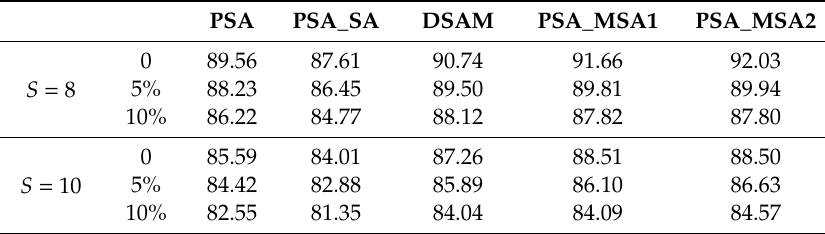
Figure 15. Comparison results of different SPM models for real land image1 with a 10% error in the proportional image ( S = 10). ( a ) PSA result, ( b ) PSA_SA result, ( c ) DSAM result, ( d ) PSA_MSA1 result, ( e ) PSA_MSA2 result. Table 9. PCC values (%) with different numbers of errors for methods based on PSA.